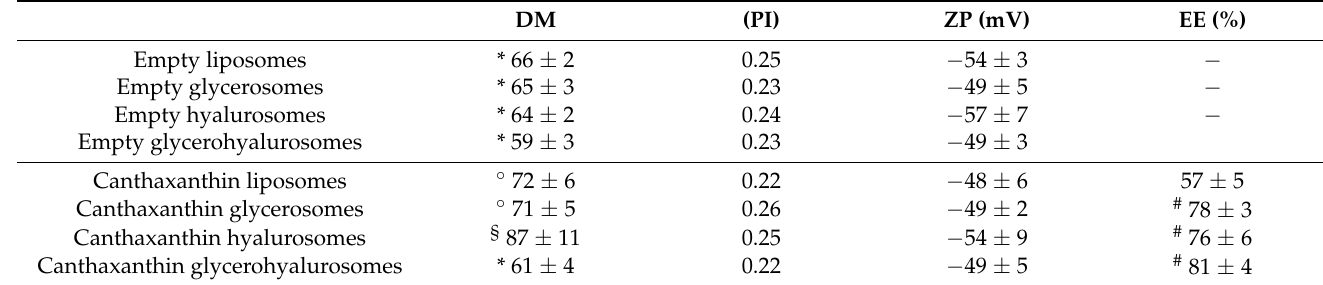
Table 2. Mean diameter (MD), polydispersity index (PI), zeta potential (ZP), and entrapment efficiency (EE) of empty and canthaxanthin-loaded vesicles. Mean values ± standard deviations are reported ( n = 6). Each symbol (*, ◦ , § , # ) indicates the same value ( p > 0.05 versus others). DM (PI) ZP (mV) * 66 ±